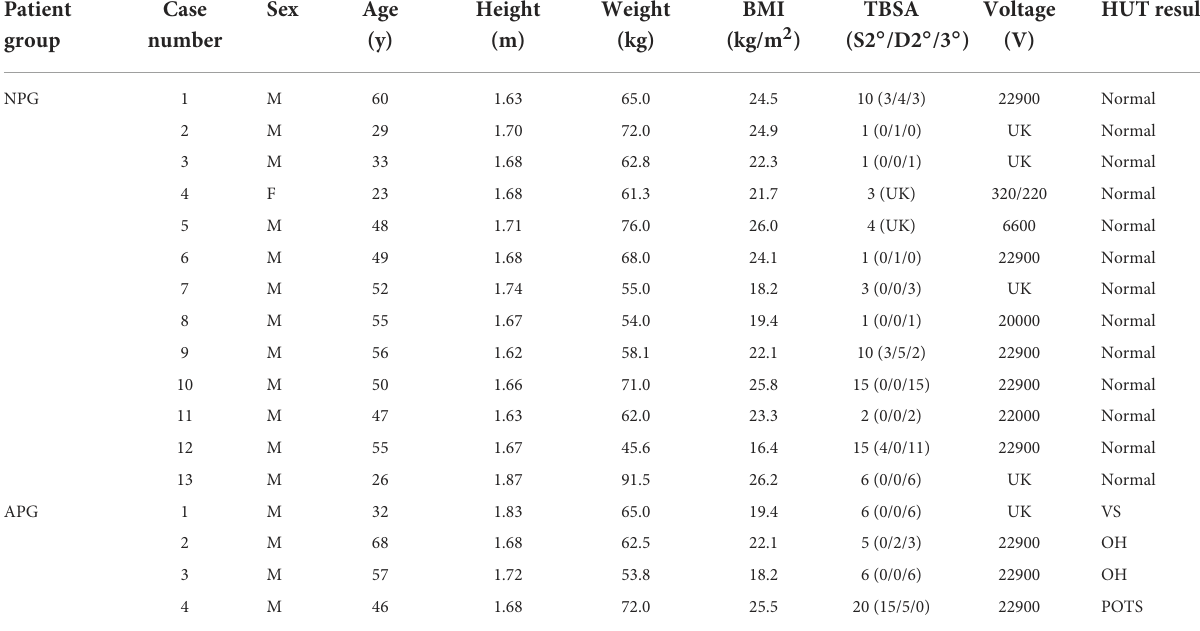
TABLE 2 Clinical characteristics of patients with electrical